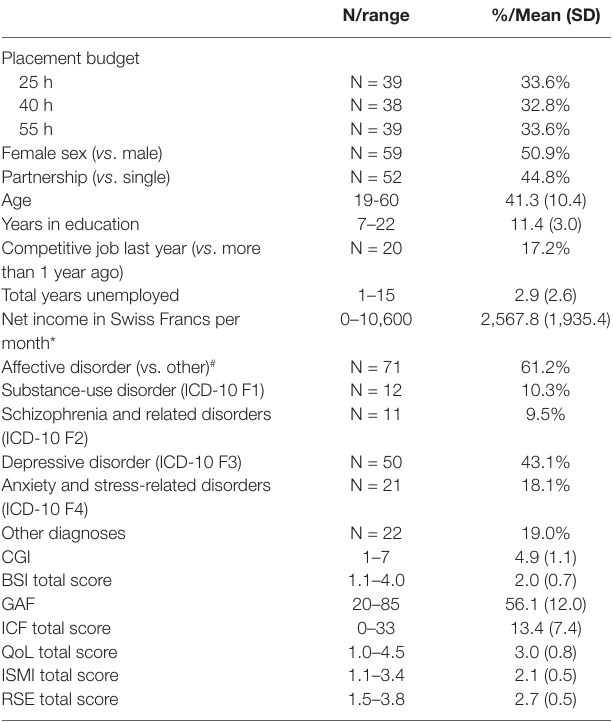
TABLE 1 | Descriptive statistics at baseline (n =